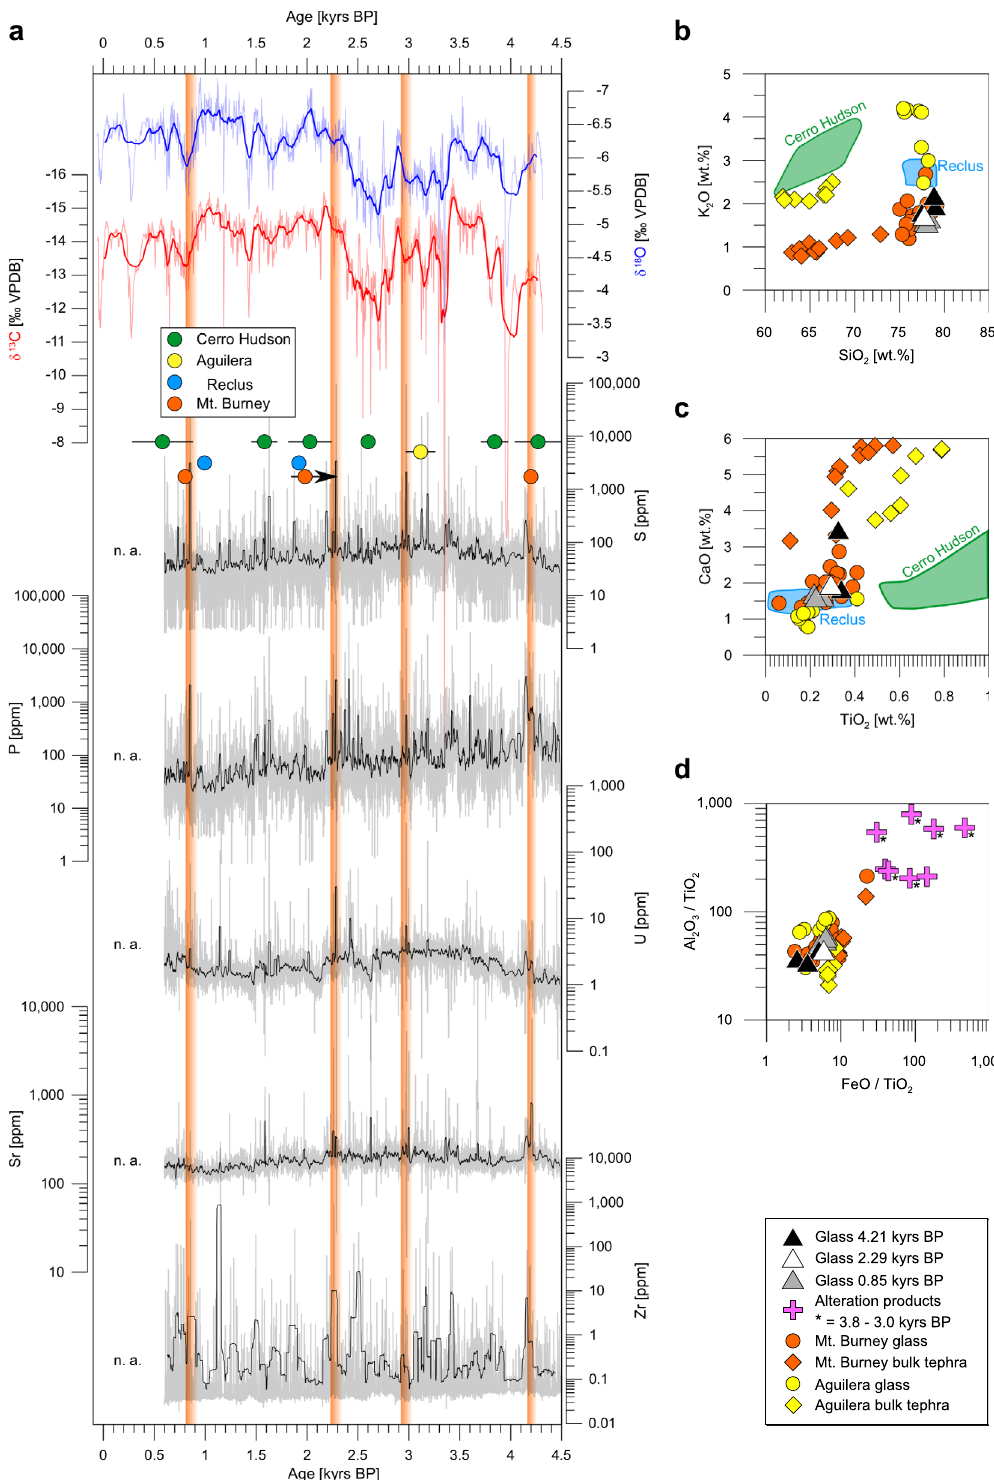
Fig. 3 Stable isotope and LA-ICP-MS data of MA1 between 4.5 and 0.6 kyrs BP combined with the geochemistry of incorporated volcanic glass and its alteration products. a δ 18 O and δ 13 C records 25 of the MA1 stalagmite combined with concentrations of S, P, U, Sr, and Zr. 14 C-ages of tephra layers from Late Holocene eruptions of volcanoes of the Southern and Austral Andean Volcanic Zone 3 are indicated. Orange bars highlight times with compositional trace element peaks at 4.216, 2.978, 2.291, and 0.853 kyrs BP. The section labeled with n.a. has not been analyzed. b – d EPMA analyses of volcanic glass and glass alteration products detected in MA1 together with single-glass shard and bulk tephra data from regional tephrostratigraphic marker horizons 5,7,8,13,36